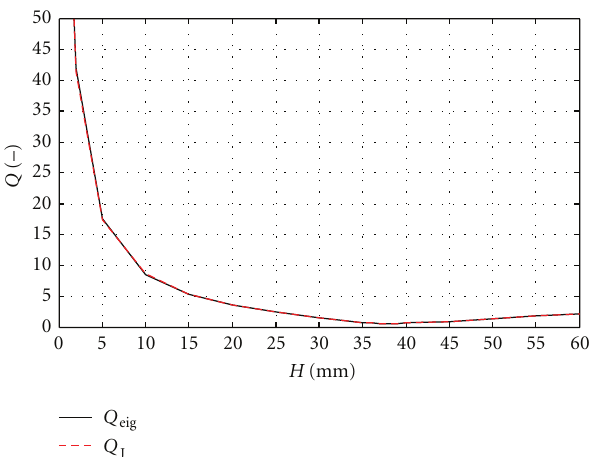
Figure 6: The radiation Q for dominant mode of an R50 × 30 patch as a function of height H